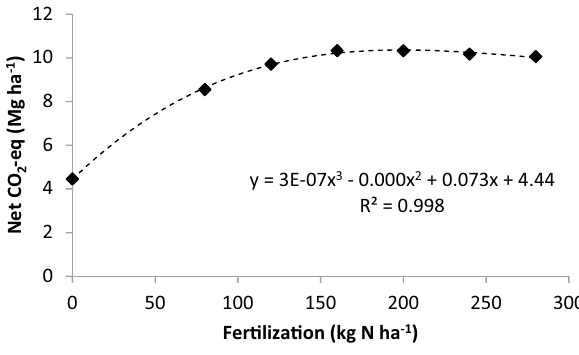
Fig. 5 Net amount of carbon dioxide (CO -eq, Mg per ha) seques- 2 tered by winter wheat grain at different fertilization levels (kg N ha −1 ). Greenhouse gas (GHG) emissions from fertilizer production, cultivation, and drying of grain deducted. Straw is an additional bonus, i.e., it is not included in these calculations. Data taken from